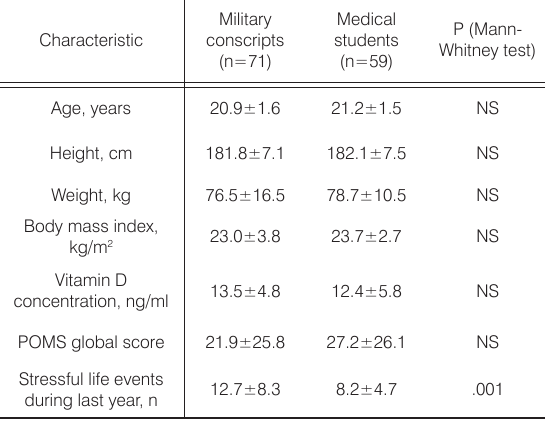
Table 1 Main characteristics of the study participants